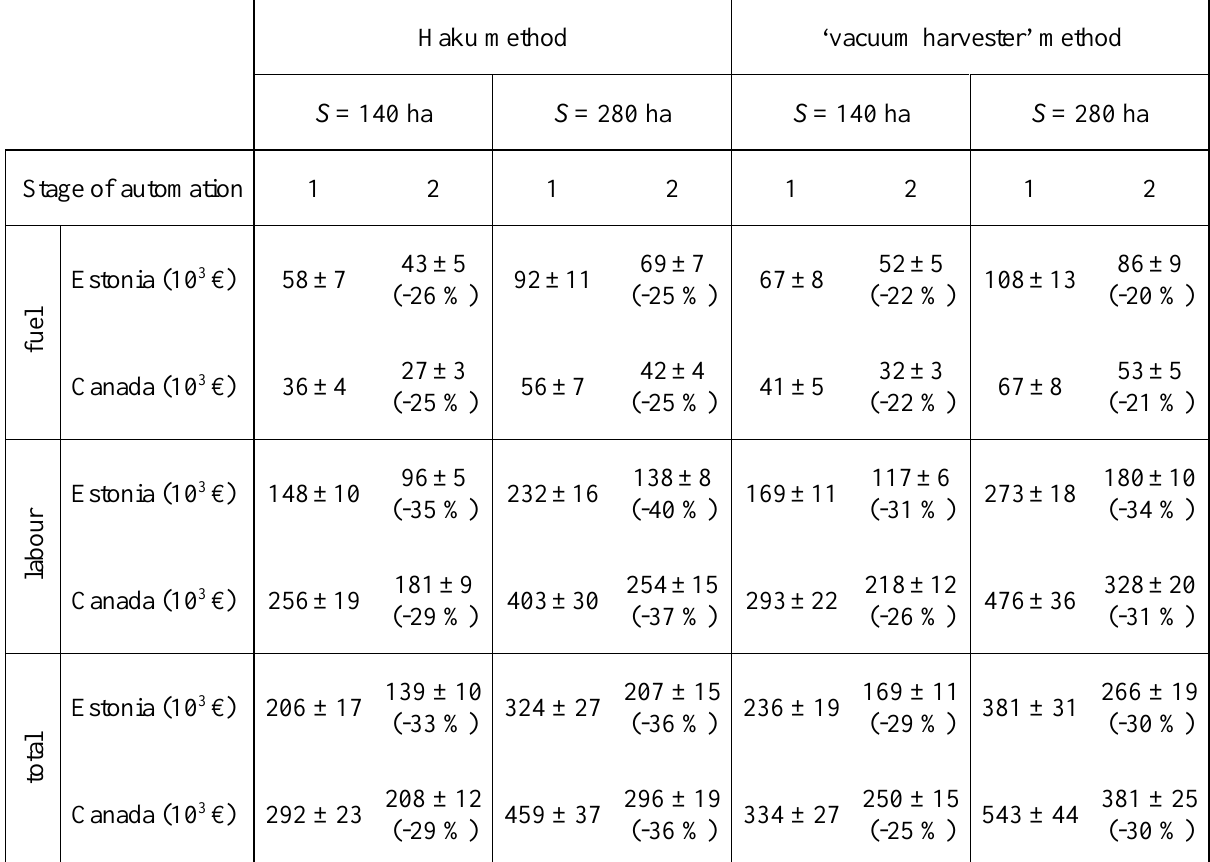
Table 3. Costs of haulage machinery fuel and labour required to work peat fields with surface areas ( S ) of 140 and 280 ha by the Haku method and the ‘vacuum harvester’ method for the duration of one extraction season, at Stage 1 and Stage 2 of automation (see Figure 1). The calculations reflect the purchase price of fuel and average salaries in Estonia and Canada as of 01 Mar 2020. For Stage 2, the values in parentheses indicate the percentage change effected by using centrally controlled UGVs (instead of conventional tractors) to haul milling and harrowing implements.